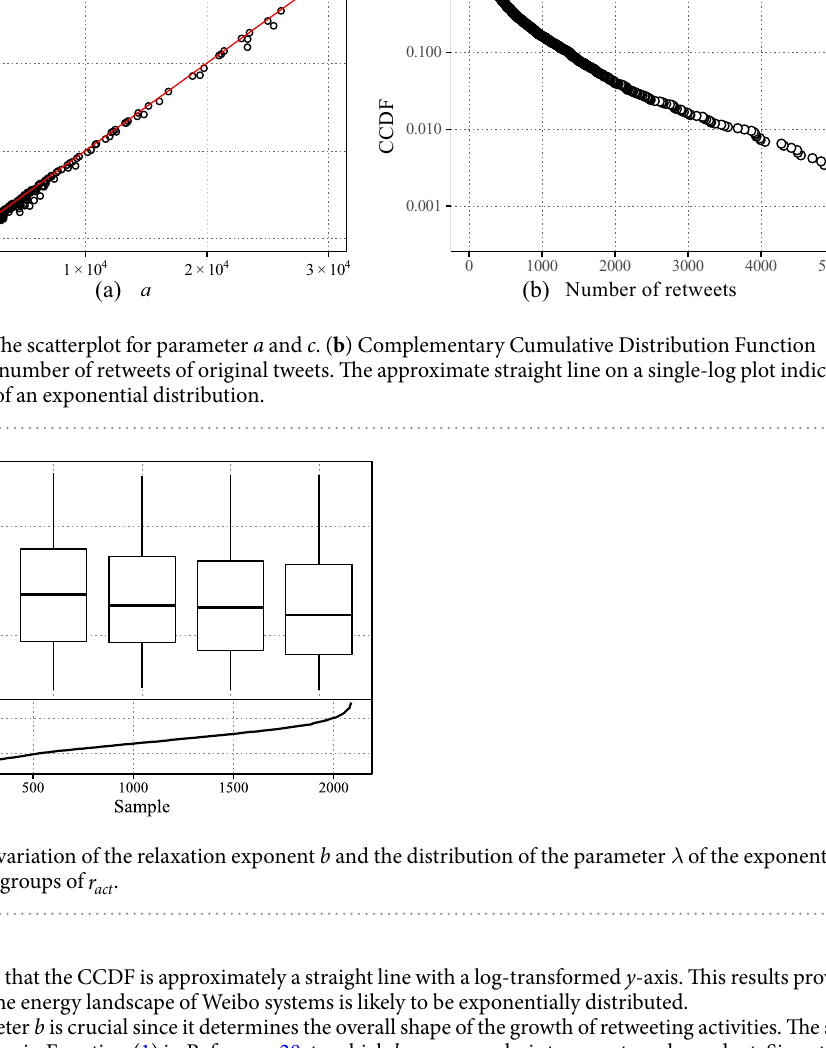
figure indicates that the CCDF is approximately a straight line with a log-transformed y -axis. This results provide evidence that the energy landscape of Weibo systems is likely to be exponentially distributed.